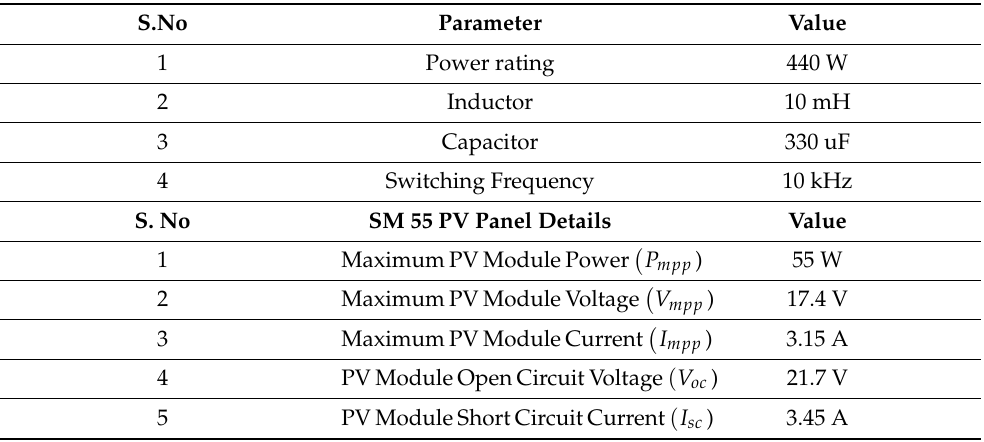
Figure 9. Various shade case of 4 × 2, 5 × 1, and 6 × 1 PV array along with its PV curve considered under study. Table 1. Technical specification of simulated system.